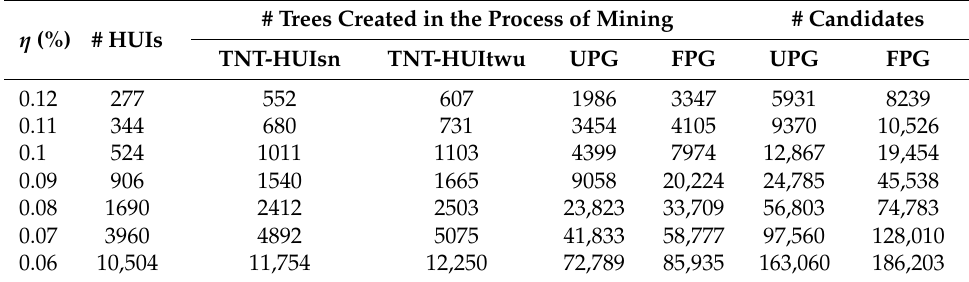
Table 8. Details analysis on the dataset T10I6D100k.